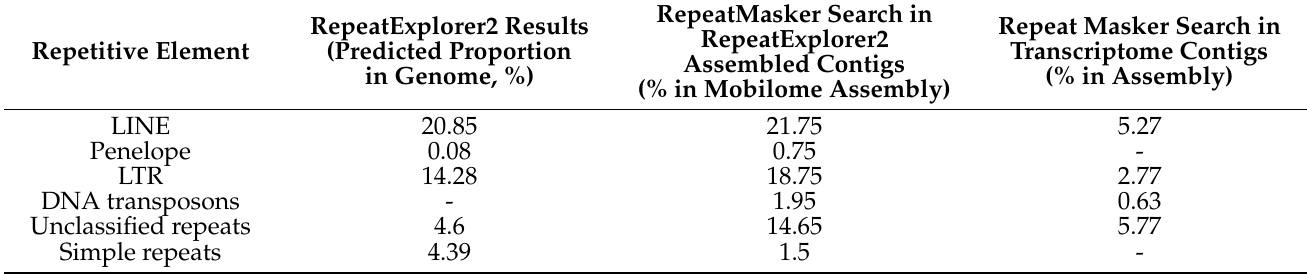
Table 2. Content of repetitive elements in the primary sequence of the genome and in the transcriptome of H. elongata .